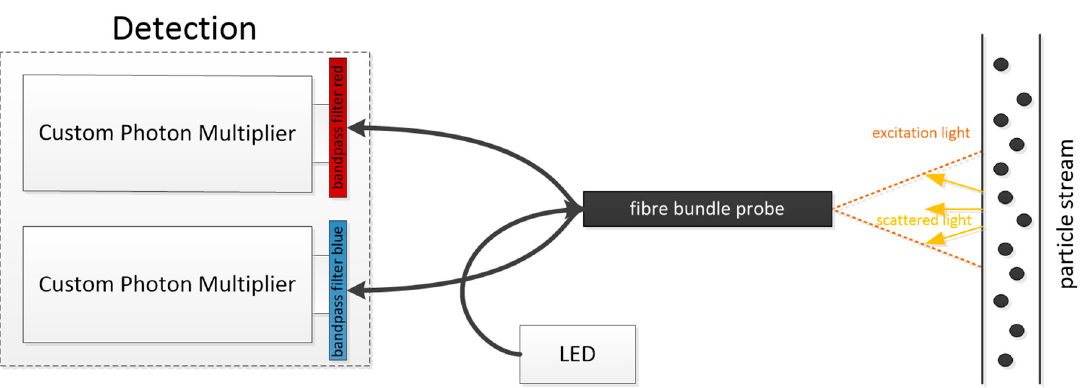
Figure 3. Detection setup with different bandpass filters [4].